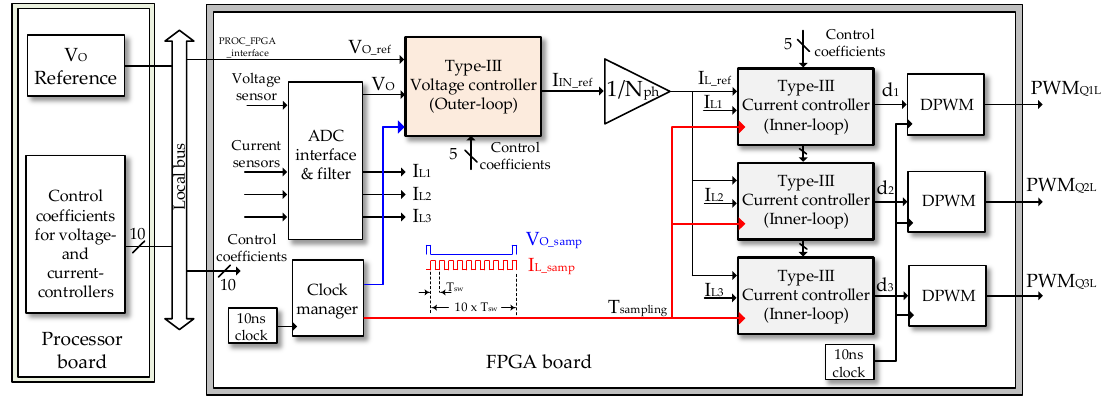
Figure 12. Block diagram of digital controller.